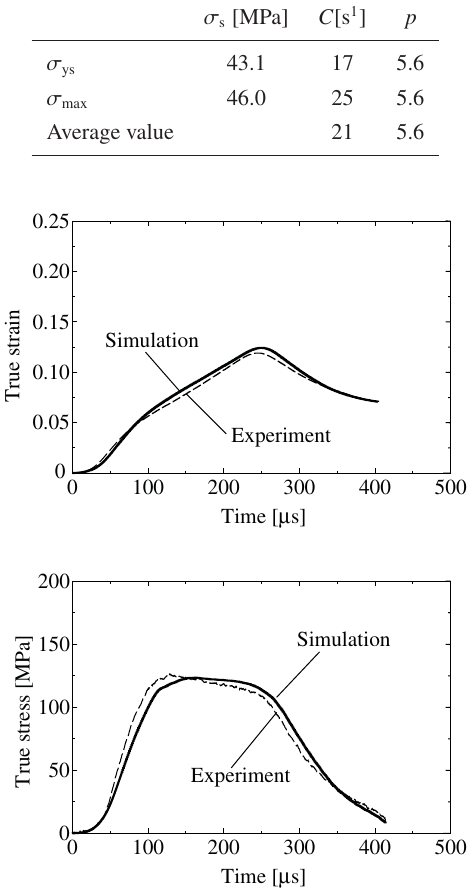
Fig. 8. Stress history and strain history at average strain rate of 550 [1 /